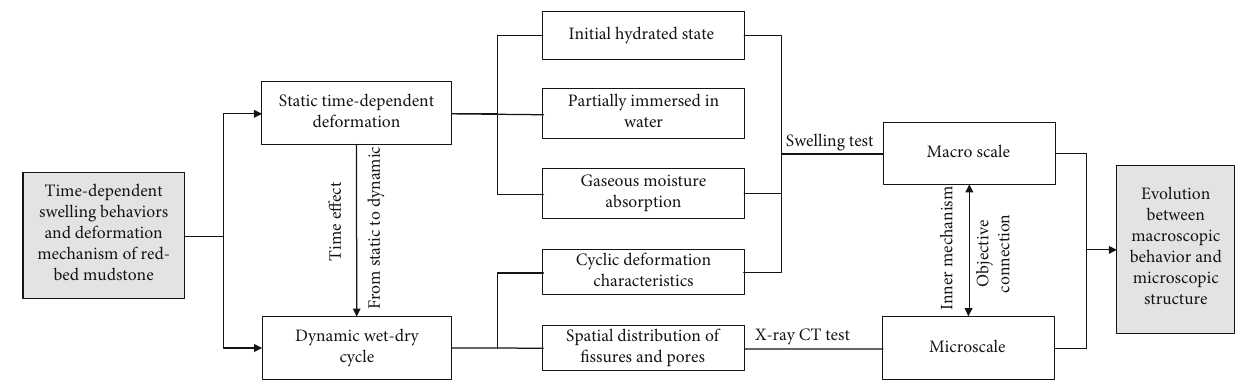
Figure 1: Overall research framework of the